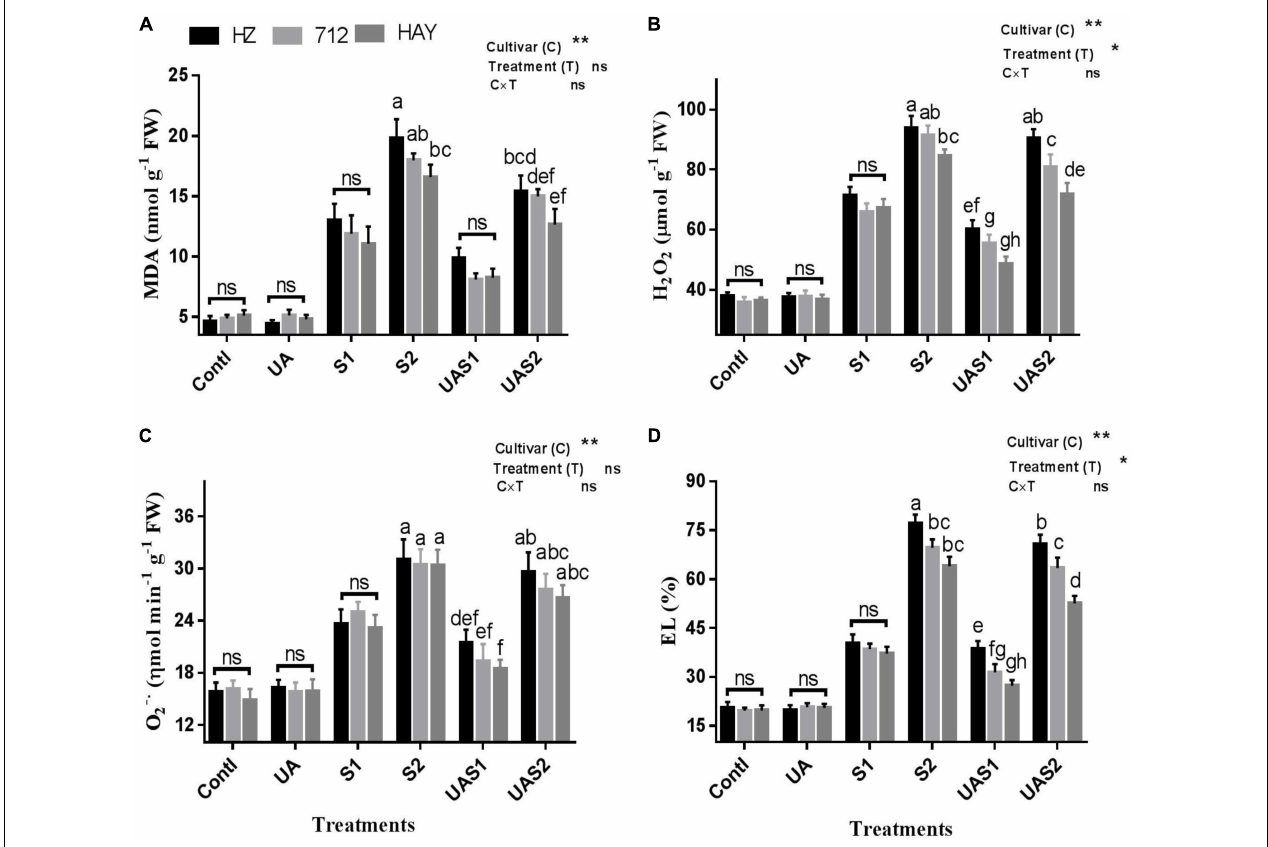
FIGURE 1 | Effect of ursolic acid (UA) on MDA (A) , H 2 O 2 (B) , O 2 − (C) , and electrolyte leakage (EL) (D) in three rice cultivars (HZ, 712, and HAY) under different salinity treatments. Means with the same letters are not significantly different based on two-way ANOVA followed by Duncan’s test ( p ≤ 0.05) for each cultivar at different salt stress treatments. The results show the mean ± SE of five replicates, and three/four plants were bulked for each replicate. Error bars represent the standard error. Contl = Control, UA = ursolic acid. S1 = 4 dS m − 1 , S2 = 8 dS m − 1 , UAS1 = ursolic acid + 4 dS m − 1 , UAS2 = ursolic acid + 8 dS m − 1 . P ≤ 0.05 (*); p ≤ 0.01 (**); ns: not statistically significant ( p >